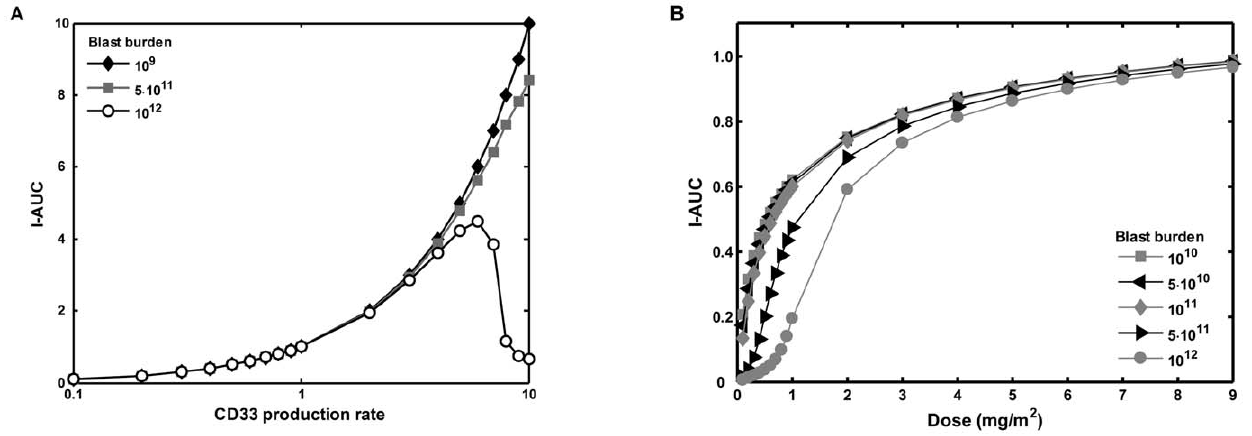
Figure 5. Effect of blast burden on intracellular exposure to GO. Parameter sensitivity analysis for CD33 production rate ( A ) and drug dose ( B ) was performed for various values of the initial blast burden (total number of blasts in the body). I-AUC and CD33 production rate are expressed in relative units as in Figure 4.